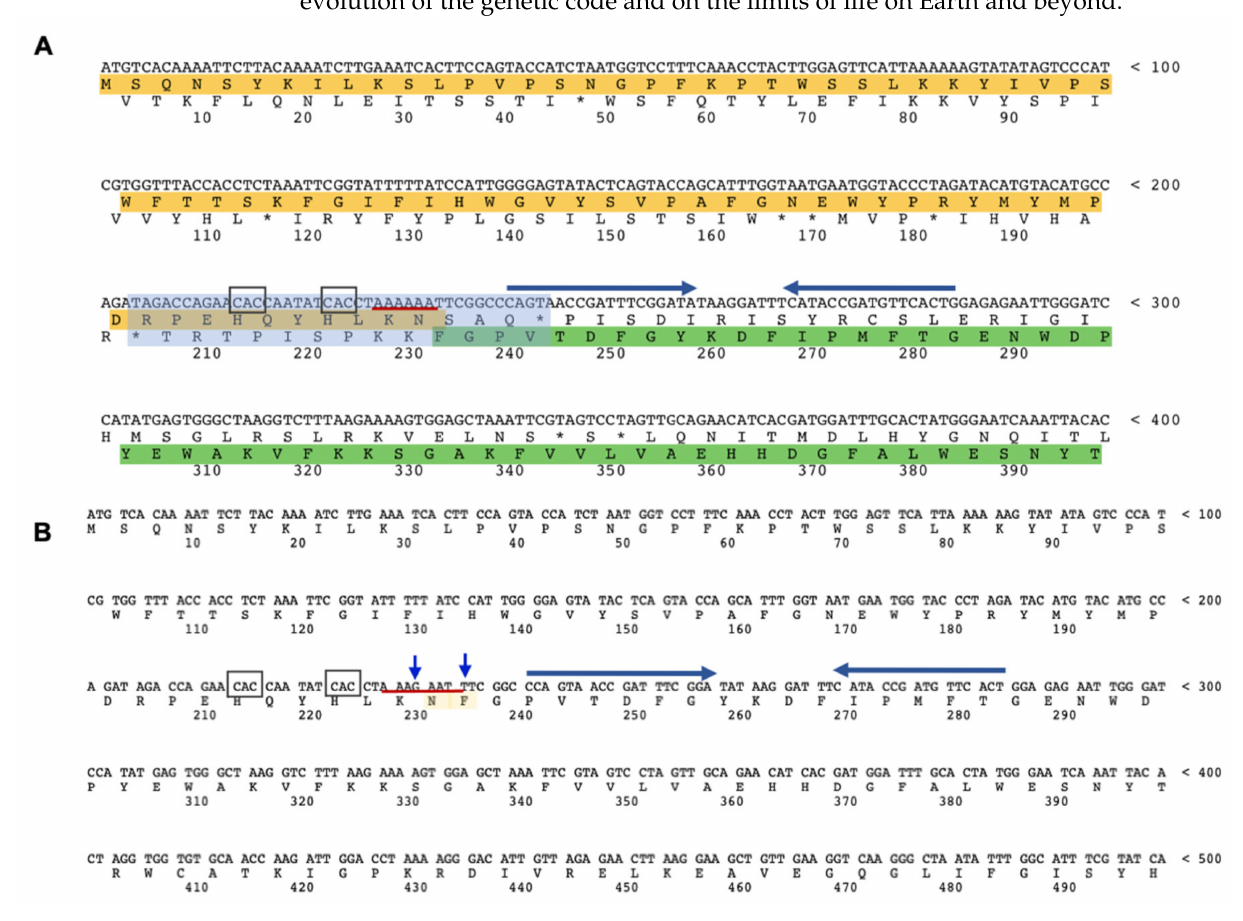
Figure 1. The α - L -fucosidase gene. ( A ) fucA gene sequence. The N-terminal SSO11867 ORF (highlighted in yellow) is in the zero frame, the C-terminal SSO3060 ORF (highlighted in green), for which only a fragment is shown, is in the − 1 frame. The 40 bp region of overlap between the two ORFs is highlighted with a light blue rectangle. The slippery heptameric sequence is underlined with a red line; the rare codons are boxed, and the arrows indicate the stems of the putative mRNA secondary structure. ( B ) framefucA mutant gene (only a fragment is shown). The blue arrows indicate the mutated nucleotides in the slippery sequence, the insertion allowing to restore a single frame between the two ORFs (involved amino acids highlighted in